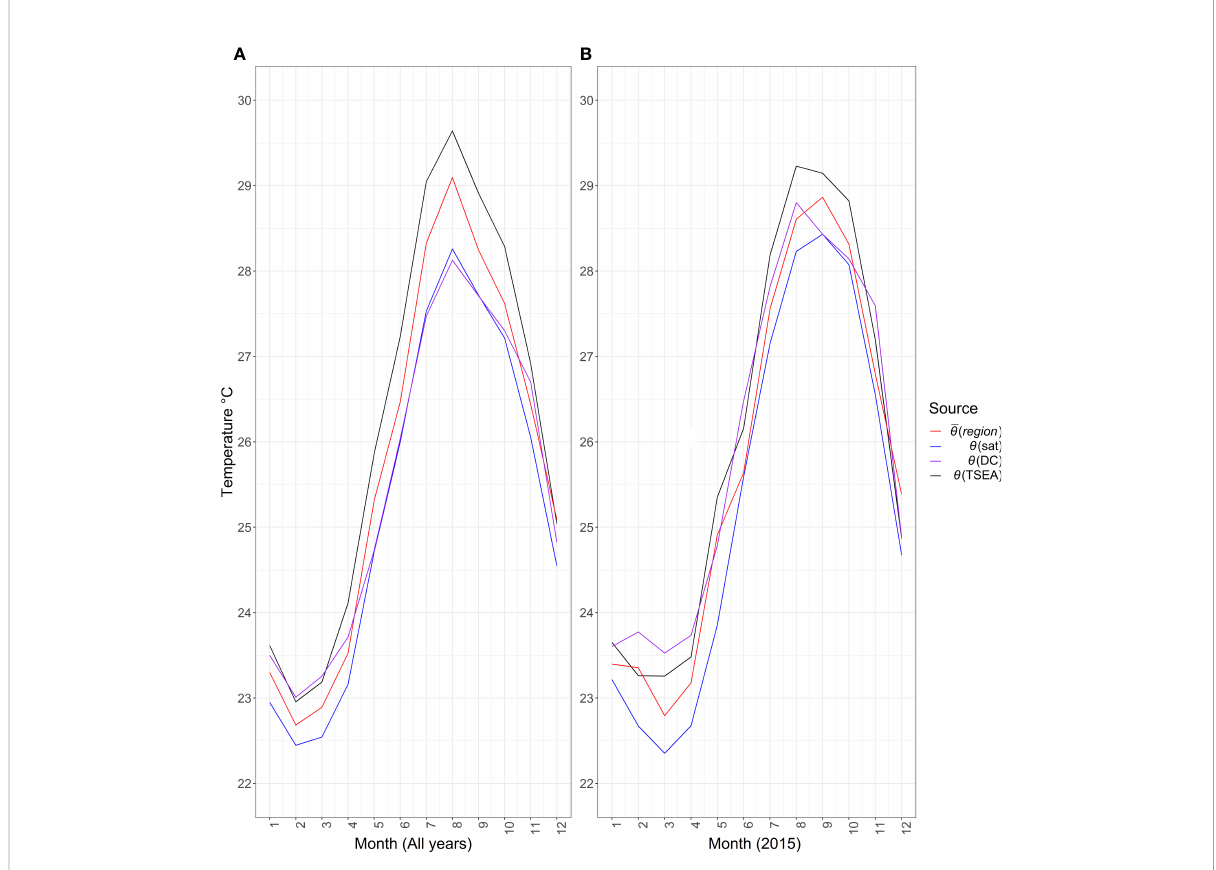
FIGURE 6 Mean monthly temperatures for q (DC), q (sat) and q (TSEA) with (cid:1) q (region) for (A) all years, (B) for an example year (2015).